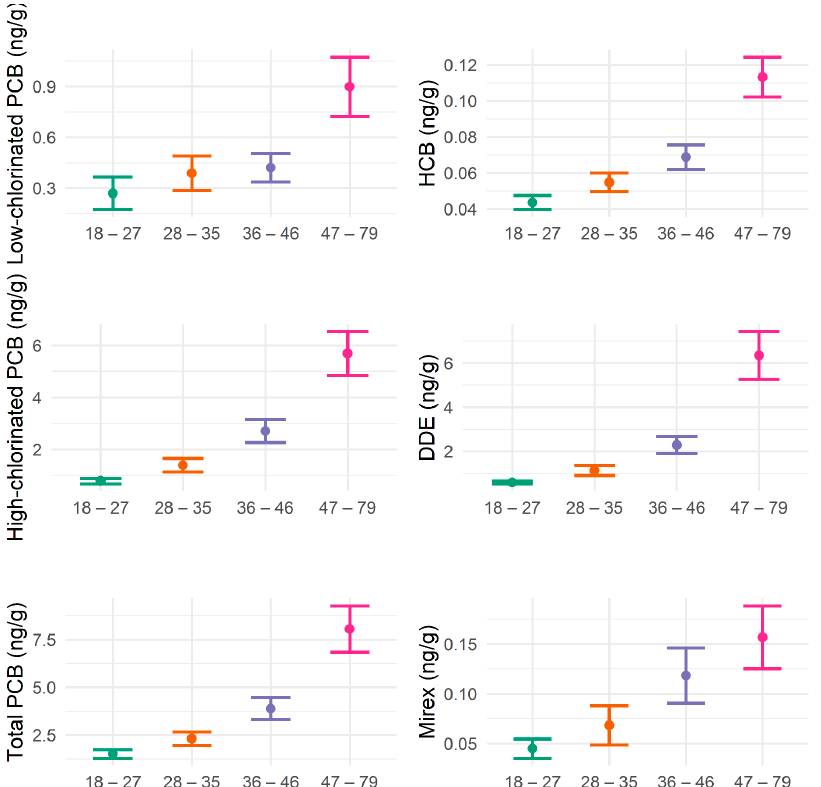
Figure 1. Means with 95% confidence intervals of serum concentrations of low-chlorinated PCBs, high-chlorinated PCBs, total PCBs, HCB, DDE, and mirex by age groups (years old) in Mohawk adults. Green color indicates the age group of 18 to 27 years old, orange is the 28 to 35 years old group, purple is the 36 to 46 years old group, and pink is the 47 to 79 years old group.